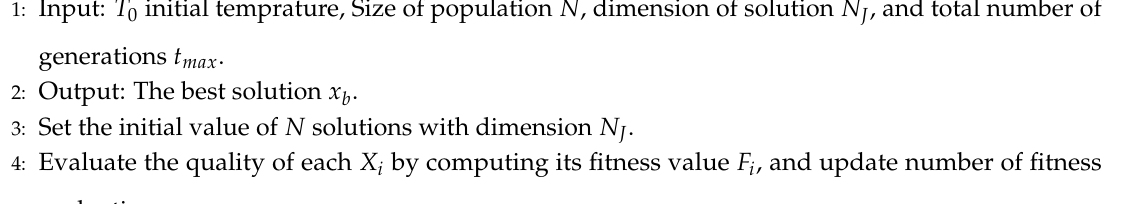
Algorithm 1 The steps of the proposed